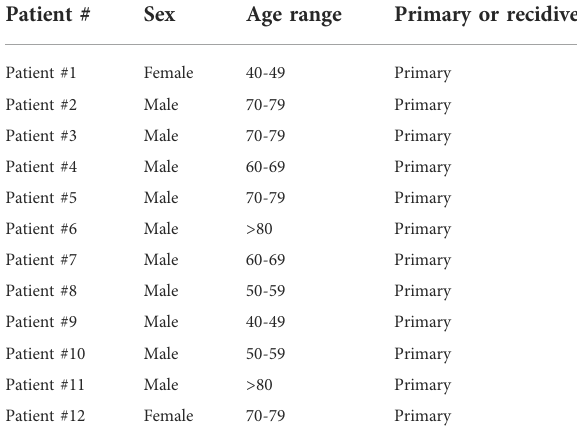
TABLE1 NMIBC patient